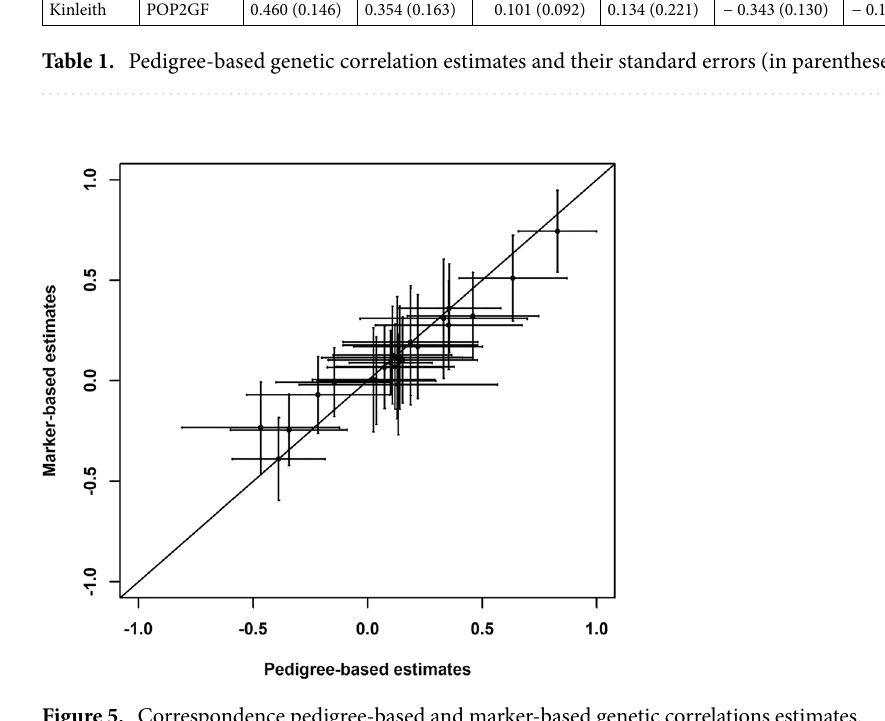
Figure 5. Correspondence pedigree-based and marker-based genetic correlations